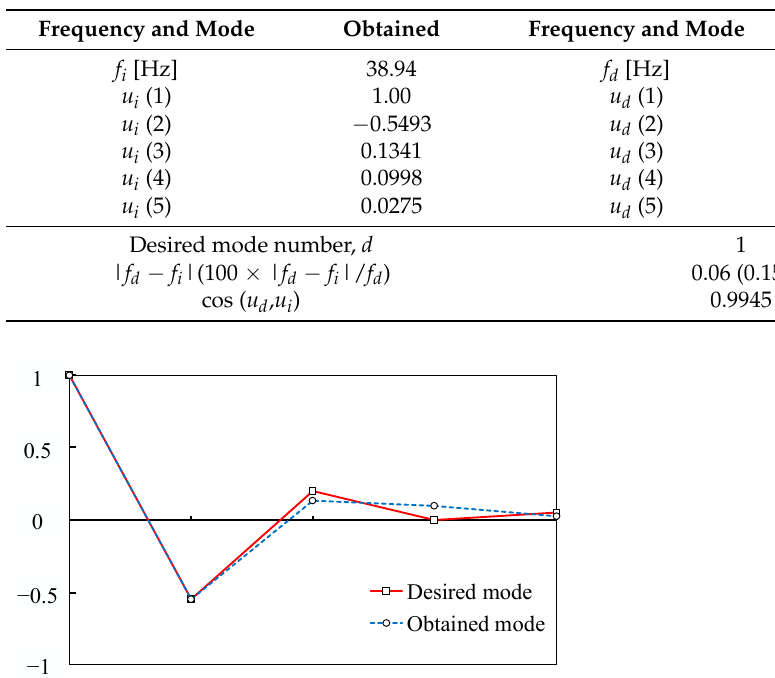
Figure 19. Original FRFs and FRFs after the simultaneous addition of masses and supporting stiffness . Table 12. Comparison of natural frequencies and mode shapes. Table 12. Comparison of natural frequencies and mode shapes.